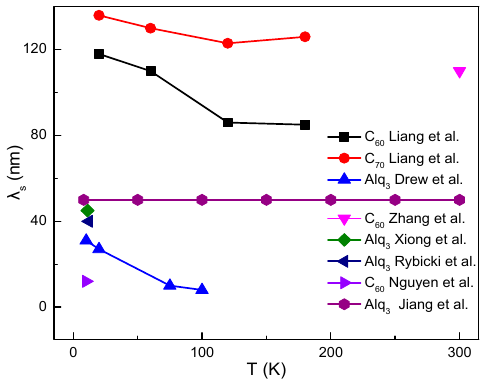
Figure 8. Spin diffusion length λ s as a function of temperature. (C 60 , C 70 Liang et al. [60]. C 60 Zhang et al. [28]. C 60 Nguyen et al. [102]. Alq 3 Xiong et al. [1]. Alq 3 Rybicki et al. [101]. Alq 3 Drew et al. [91]. Alq 3 Jiang et al. [112].)